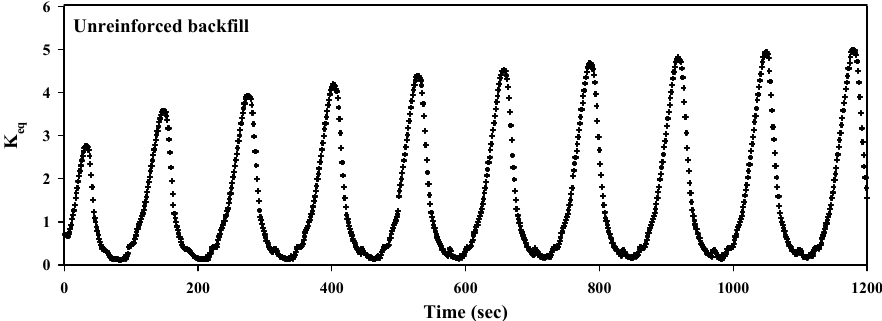
Figure 10. Variation of the equivalent lateral earth pressure coefficient ( K eq ) of unreinforced backfill.